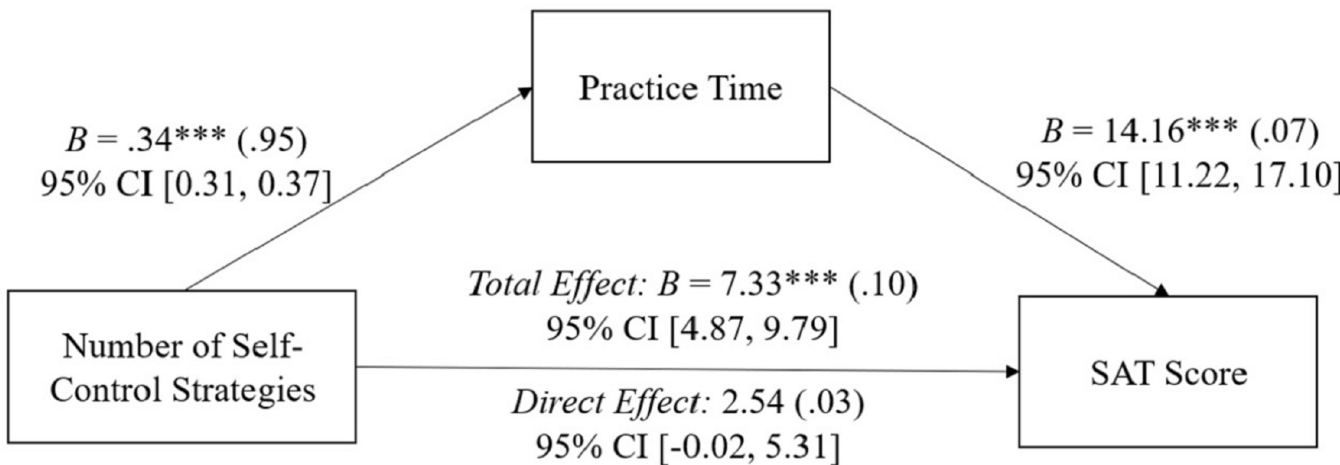
Fig 2. Study 1 practice time mediating the relationship between number of self-control strategies and SAT scores. Study 1 practice time mediates the relationship between the number of self-control strategies and SAT scores. B represents the unstandardized beta coefficient (standardized beta coefficients in parentheses). Covariates include the squared strategic self-control term, students’ PSAT scores, gender, fee waiver status, and ethnicity. ��� p < .001.